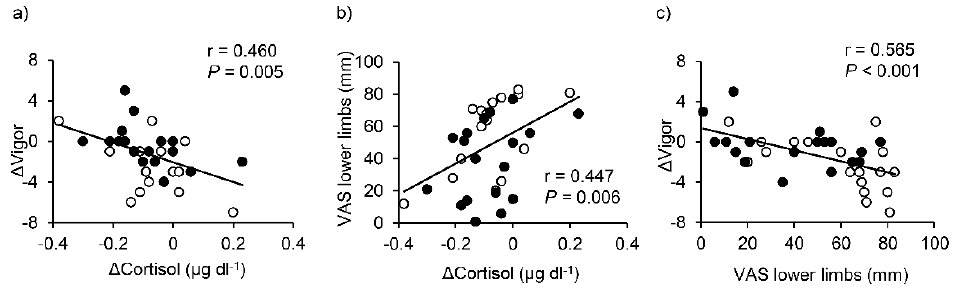
Figure 5. Relationships between changes ( ∆ ) in saliva cortisol (difference between pre–and post–3 h sitting) and changes in Vigor subscale of Profile of Mood Scale (panel a ), between changes in saliva cortisol and lower limbs VAS (panel b ), and between lower limbs VAS and changes in Vigor (panel ( c ). Data for both conditions are pooled; thus, sample size was 36 as 18 participants × two conditions. Each symbol means the same as in Figure 3.